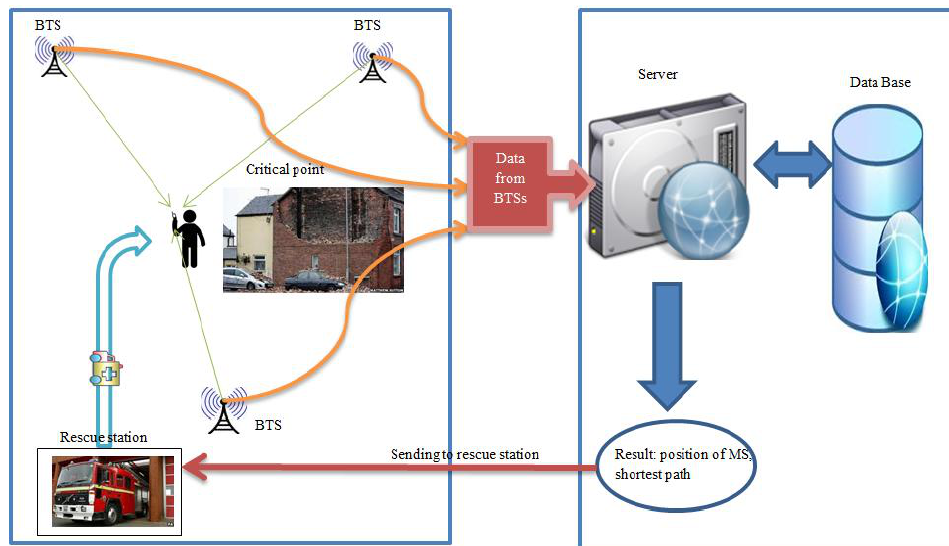
Figure 6. GIS based architecture for post-earthquake crisis management